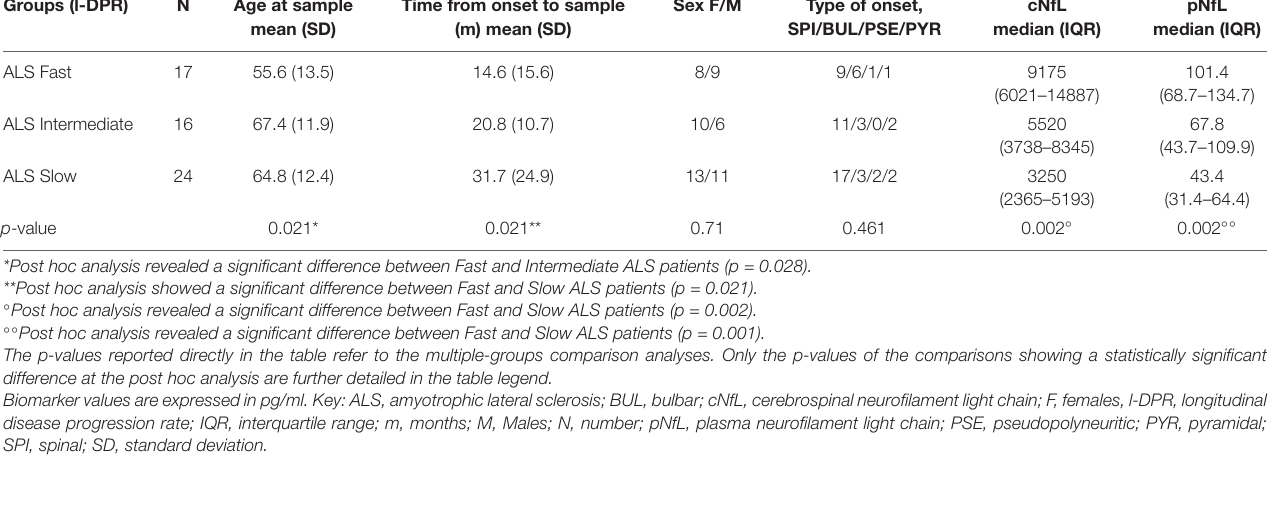
TABLE 5 | Longitudinal ALS cohort: patients’ characteristics and biomarkers stratification according to the l-DPR. Groups (l-DPR)